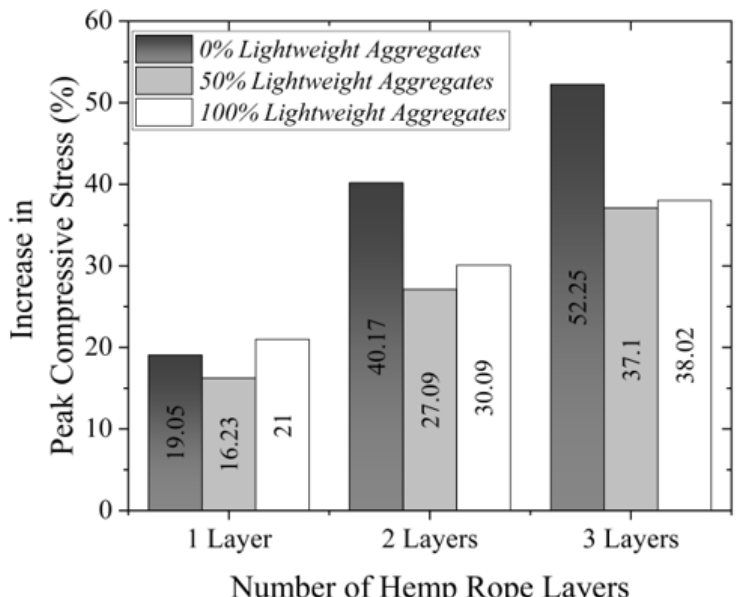
Figure 7. Effect of lightweight aggregate content on strength gain.